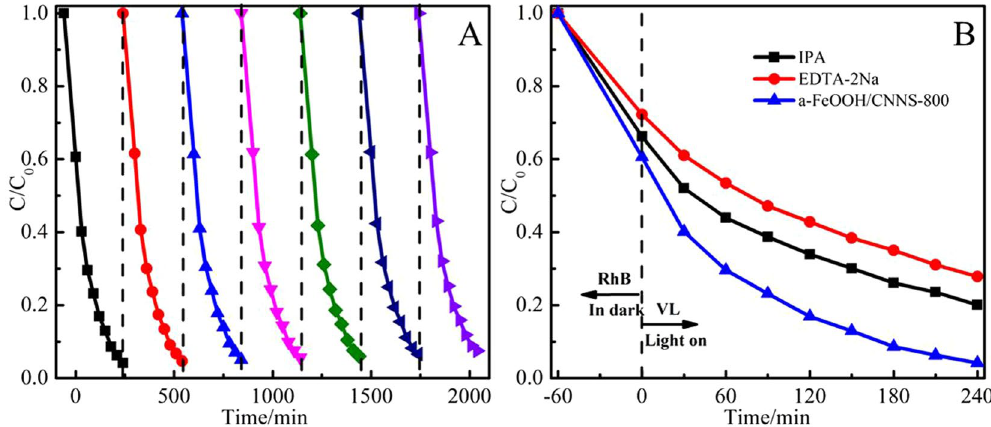
Figure 11. ( A ) Stability of a-FeOOH/CNNS-800 composite for RhB degradation under visible light irradiation. ( B ) Radical trapping experiments during the photocatalytic degradation of RhB over a-FeOOH/CNNS-800 composite under visible light